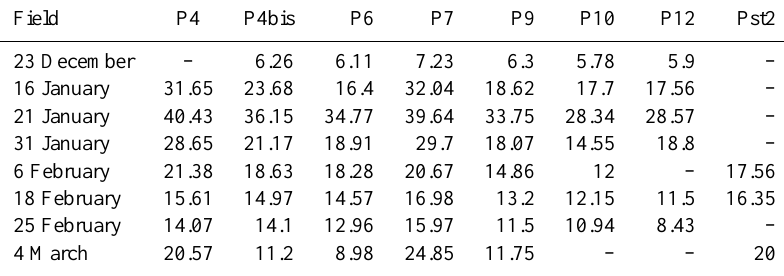
Table 2. Gravimetric volumetric soil moisture measurements (%) over test fields.